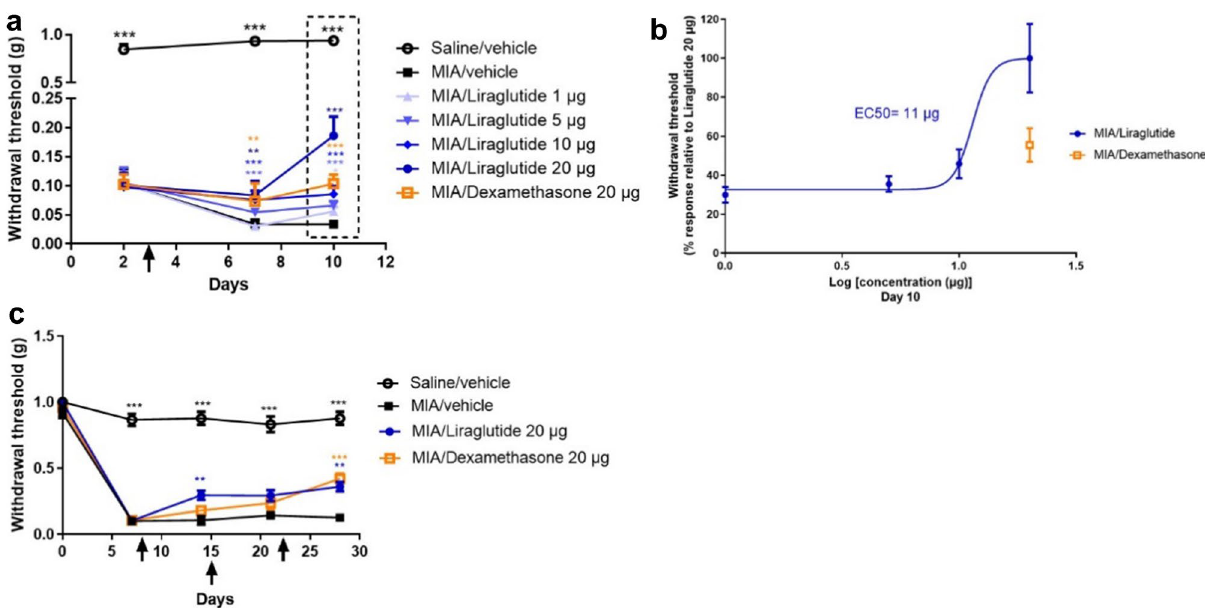
Figure 2. Liraglutide displayed analgesic effect in MIA mice models of OA. Mice knee joints were intra- articularly (IA) injected with 0.75 mg of MIA or saline on day 1. For the short-term study ( a,b ), treatments (liraglutide, dexamethasone, or vehicle) were injected IA on day 3 and inflammation pain sensitivity was determined by the von Frey test on day 2 (for randomization), 7, and 10 (n = 15–19 per group). For the long- term study ( c ), treatments were administered on days 8, 15, and 22, and von Frey tests were performed on day 7 (for randomization), 14, 21, and 28 (n = 9–10 per group). ( a ) Paw withdrawal threshold was assessed by von Frey filament stimulation on days 2, 7, and 10. ( b ) The efficacy rate of liraglutide in the MIA short-term study was analyzed using GraphPad Prism 9.0 and the EC 50 value was determined at day 10 from the von Frey calculated values. ( c ) Paw withdrawal threshold was assessed by von Frey filament stimulation on days 0, 7, 14, 21, and 28. Arrows indicate the treatment with IA administration. Statistical analysis: Mean ± SEM. Mann–Whitney test with sequential strategy, ** p < 0.01, *** p < 0.001, **** p < 0.0001 versus MIA